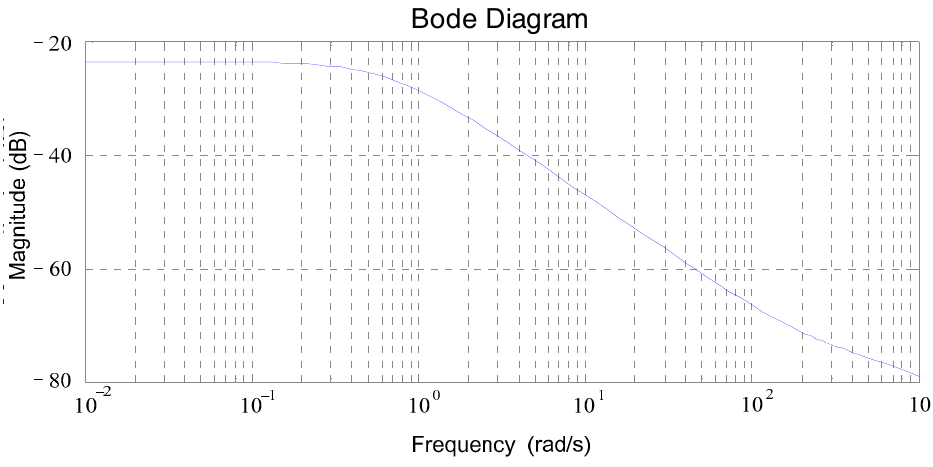
Figure A8. Sensitivity of system using wheel speed